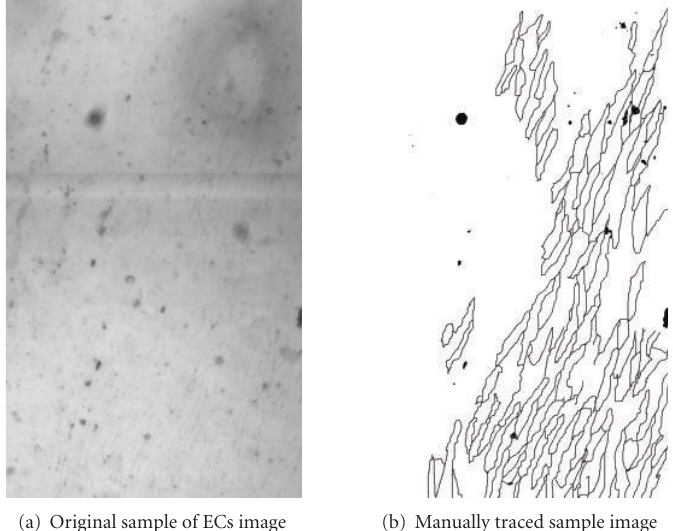
Figure 1: Original sample of ECs and corresponding manually traced image using the GNU Image Manipulation Program (GIMP)